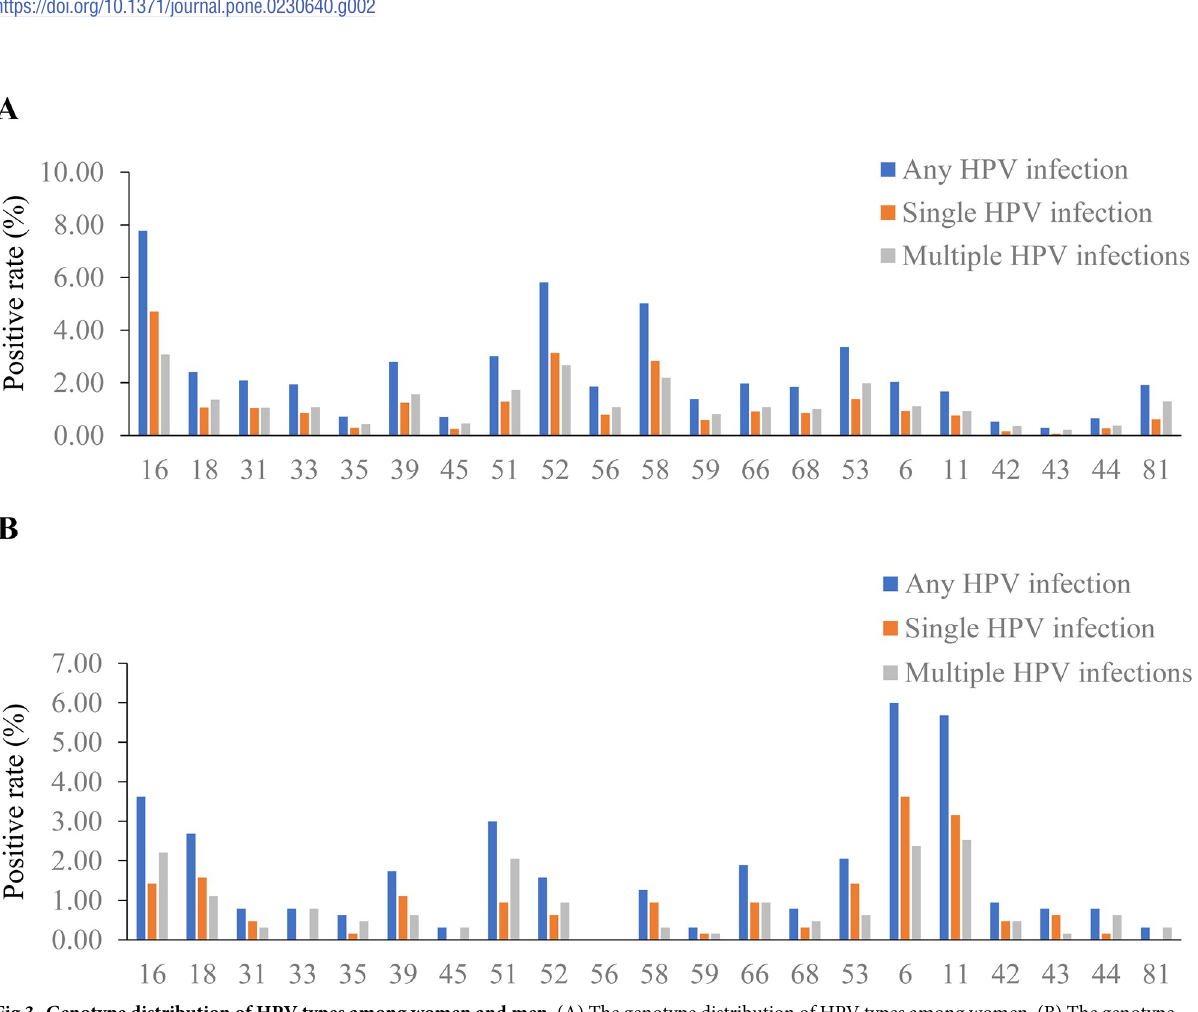
Fig 3. Genotype distribution of HPV types among women and men. (A) The genotype distribution of HPV types among women. (B) The genotype distribution of HPV types among men.